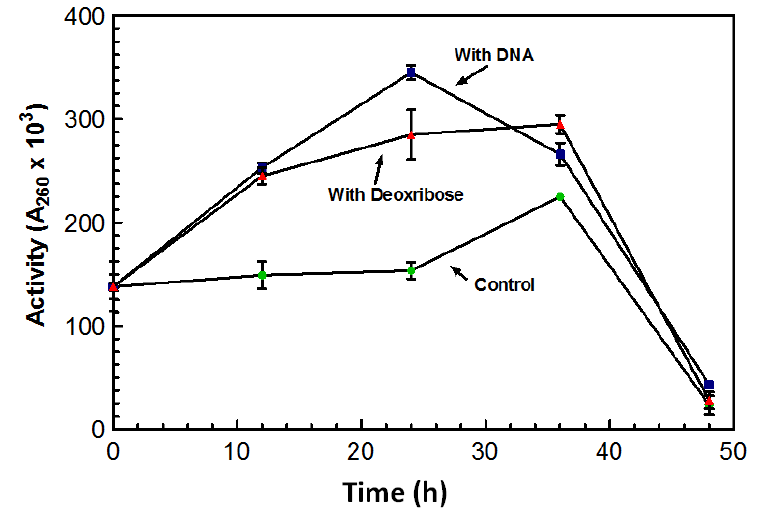
Figure 3. Profile of DNase production in the presence of DNA or deoxyribose. All flasks were incubated for five days (120 h) in the absence of exogenous DNA with agitation (100 RPM). After the fifth day, 1 g of filter sterilized DNA (10 mL) or 1 g deoxyribose was added to a set of flasks and incubated with agitation for 50 h at 55 °C. Control flasks were similarly incubated without the addition of DNA. Activity was measured using the acid soluble assay with a 60 min. incubation time at 55 °C. All assays were performed in triplicate using triplicate